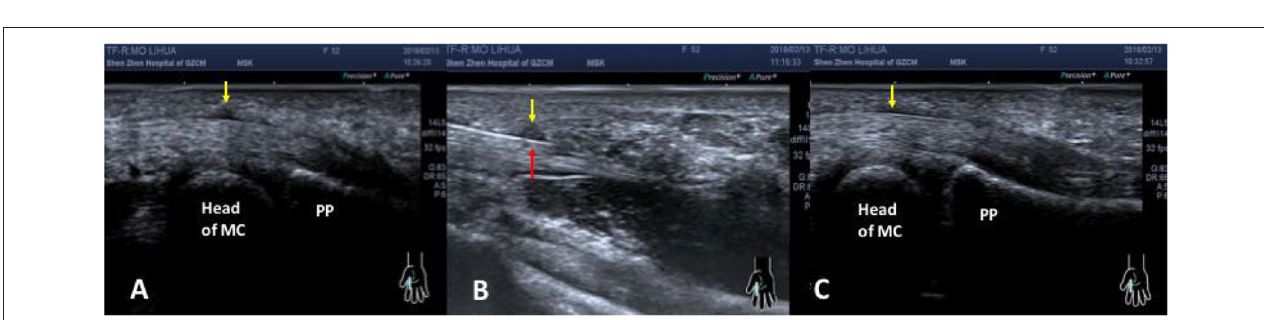
FIGURE 6 | The scheme (A) and spot (B) of the ultrasonography-guided release. The body of the needle knife paralleled to the tendon. With the help of ultrasound, it was easy and safe to complete the whole procedure.